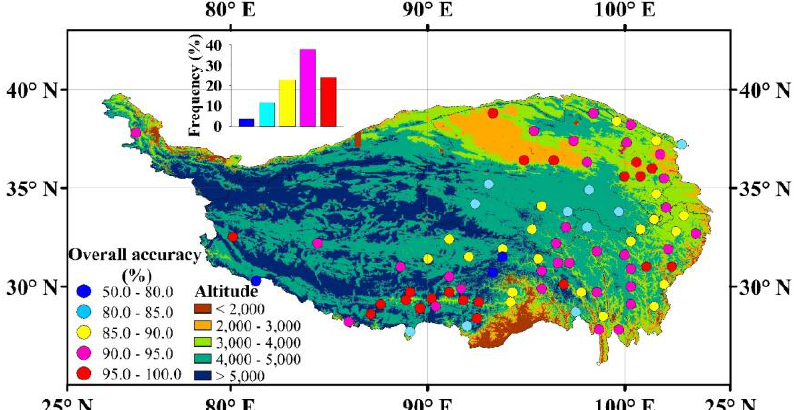
Figure 4. Distribution of overall accuracy (OA) during the period of 2000–2011 in the Qinghai-Tibetan Plateau. The inset graph above shows the frequency distributions of the corresponding overall accuracy.